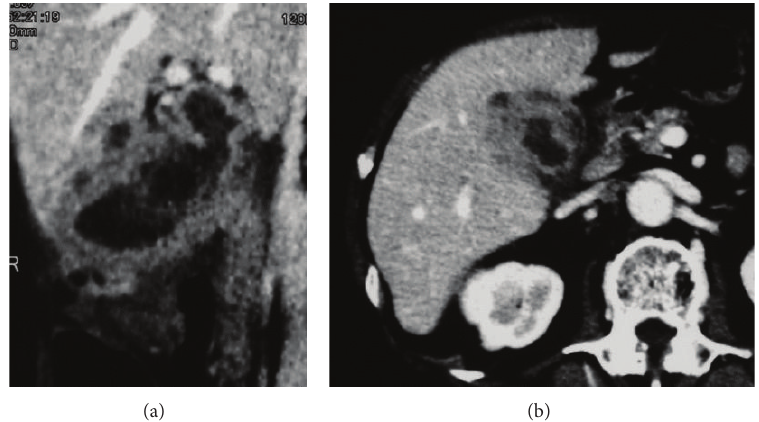
Figure 2: Longitudinal image of chronic cholecystitis. A case of cholecystitis mimicking gallbladder cancer. Uniform mucosal enhancement was observed. There was diffuse wall thickening with no parenchymal enhancement in the liver (a). The border between the gallbladder and liver parenchyma was unclear on horizontal images